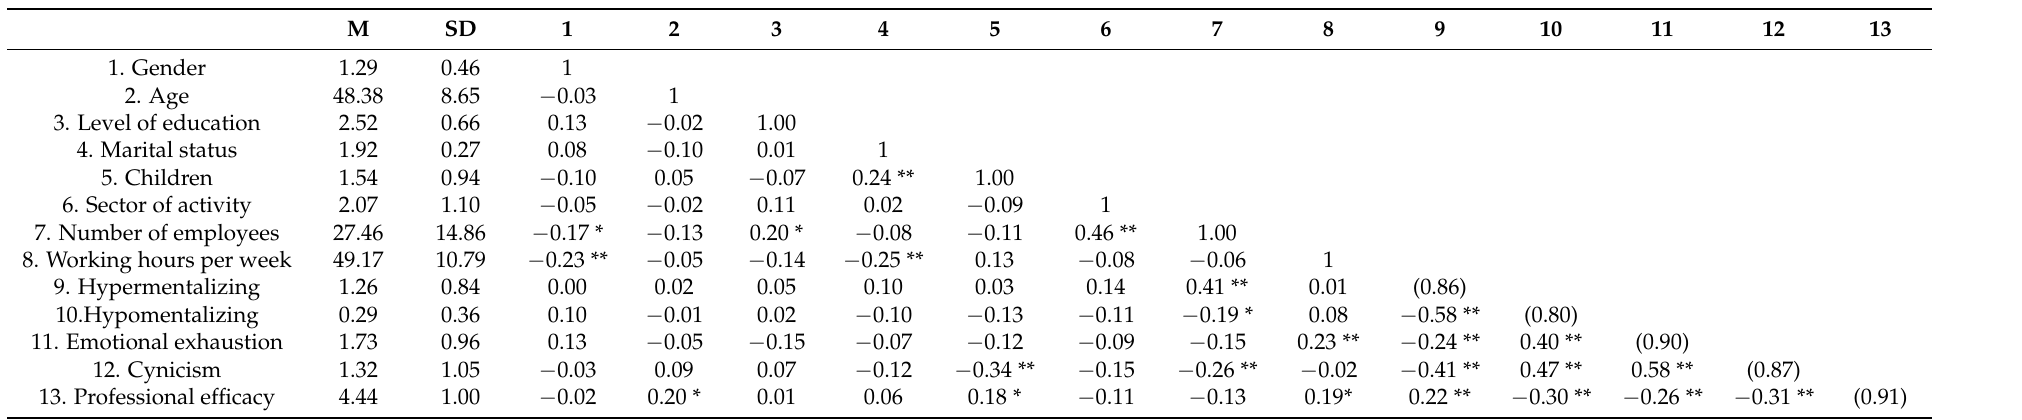
Table 1. Mean (M), standard deviation (SD), and correlations between